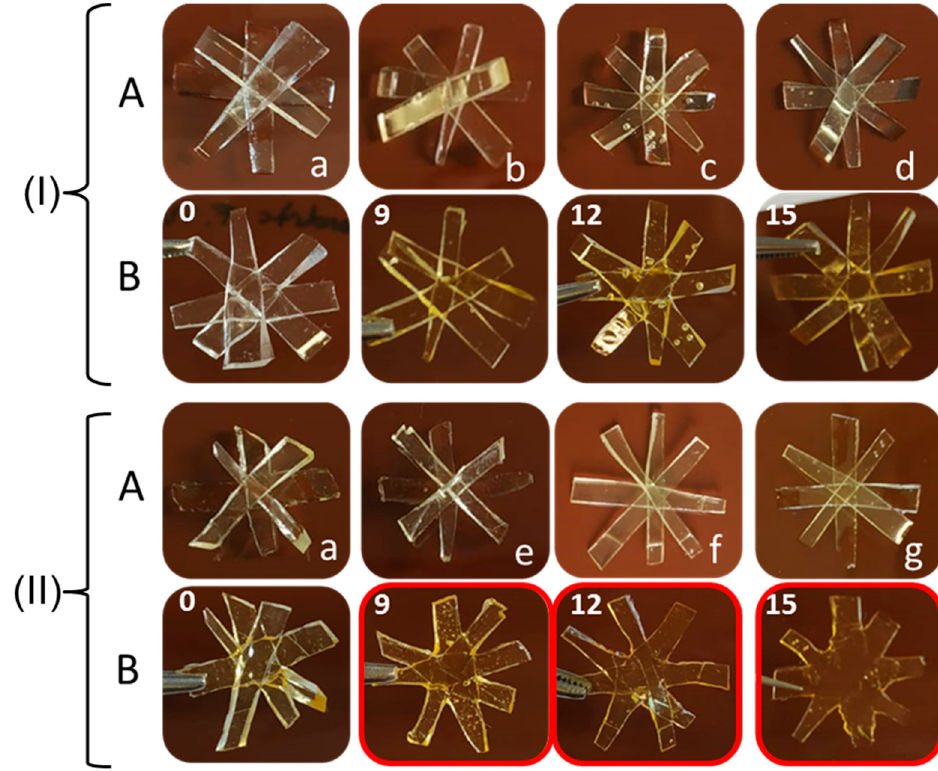
Figure 12. Photographs of adhesive samples before ( A ) and after ( B ) thermal treatment at 120 °C for 15 min. (I): ( a ) PURSF-01 reference, ( b ) PURSF-03 (9 %TB), ( c ) PURSF-04 (12 %TB) and ( d ) PURSF-05 (15 %TB) samples. (II): ( a ) PURSF-01 reference, ( e ) PURSF-07 (9 %TB), ( f ) PURSF-08 (12 %TB) and ( g ) PURSF-09 (15 %TB) samples.